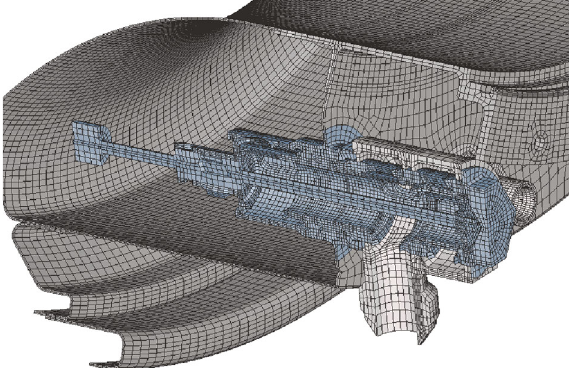
Figure 3: Oil tank fi nite element model.